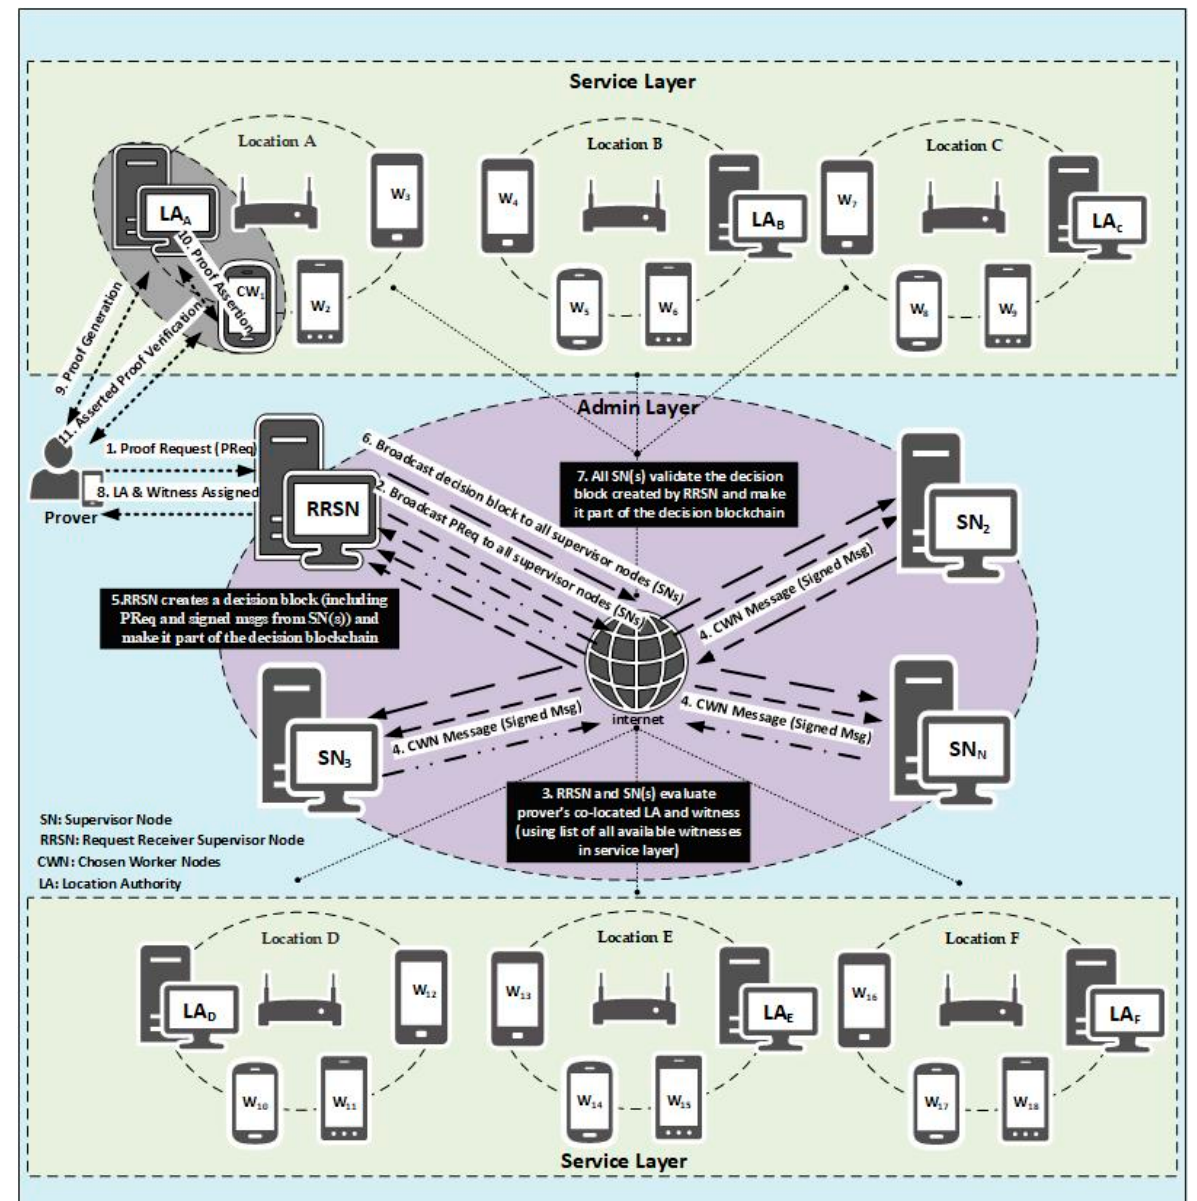
Figure 1. MobChain architecture